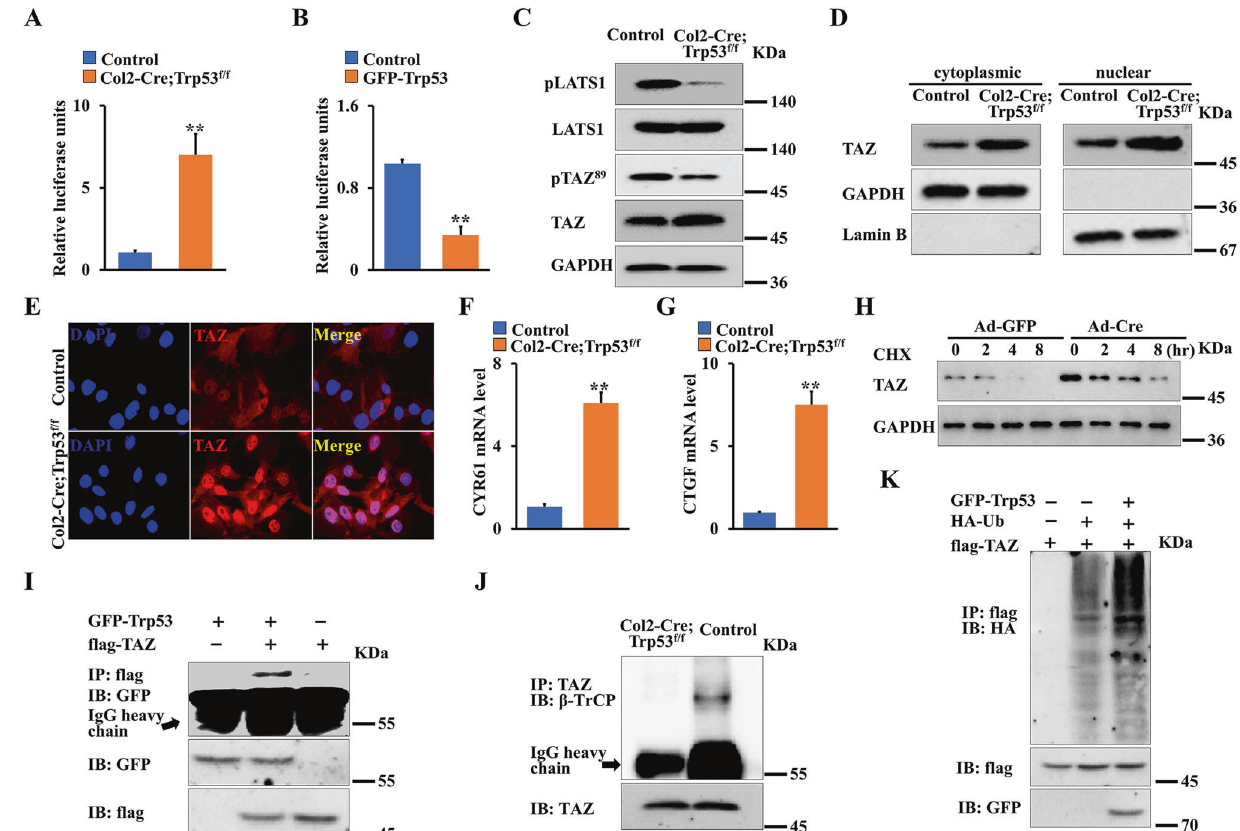
Fig. 5 Trp53 regulates the stability and activity of TAZ in chondrocytes. A The luciferase activity was measured by Promega ® Luciferase Assays kit in primary chondrocytes as indicated. B Luciferase activity was measured in the primary chondrocytes the following co-transfection with pEGFP (control), pEGFP-Trp53, respectively. C Whole protein lysates of primary chondrocytes as indicated were detected by western blot. D TAZ expression in cytoplasm and nucleus as indicated. E Representative fl uorescence images of TAZ in primary chondrocytes as indicated. Scale bars, 25 μ m. F , G mRNA level of CYR61 and CTGF in primary chondrocytes as indicated. H Primary chondrocytes from Trp53 f/f mice were transfected with Ad-Cre or Ad-GFP, after 24 h, the cells were treated for different time as indicated with 50 μ g/mL cycloheximide (CHX). The TAZ expression was identi fi ed by western blot. I Co-IP experiments were performed after transfection of plasmid GFP-Trp53 or/and fl ag-TAZ in HEK293T cells as indicated. J Co-IP experiments in primary chondrocytes as indicated. K Western blot analysis of TAZ ubiquitination demonstrating that Trp53 is necessary for TAZ ubiquitination. ** P <